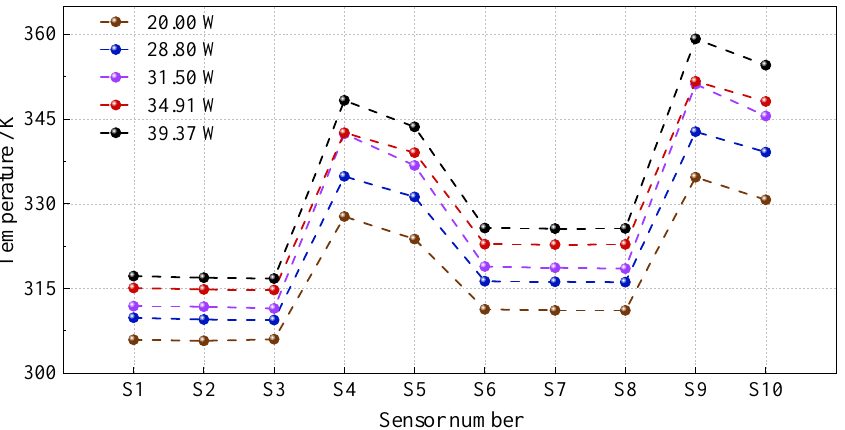
Figure 6. Average temperature of the sensor at steady state. The temperature difference ∆ T in Newton’s cooling formula and Gr is taken as T w − T ∞ , as shown in Figure 7a. The ∆ T increases approximately linearly with the in- crease in power. The thickness of the boundary layer increases with height during laminar flow, and the thermal resistance of laminar heat transfer increases, resulting in a greater T w − T ∞ in the middle section (S6 ∼ S10) of the vertical tube than T w − T ∞ in the lower part of the vertical tube (S1 ∼ S5). Assuming that the copper tube has no axial heat dissipation, the heat transferred radially by the tube per unit of time is approximately the power given by the single-phase voltage regulator. According to the experimental data and Newton’s law of cooling in Equation (11), the natural convective heat transfer coefficient under dif- ferent qualitative temperatures T m can be obtained, as shown in Figure 7b. The middle section’s coefficient is smaller than that in the lower part of the vertical tube due to the difference in characteristic length. The natural convective heat transfer coefficient linearly increases with the increase in qualitative temperature. The linear relationship is obtained by the least square fitting method, and the R 2 values of of S1 ∼ S5 and S6 ∼ S10 are 0.973 and 0.928,